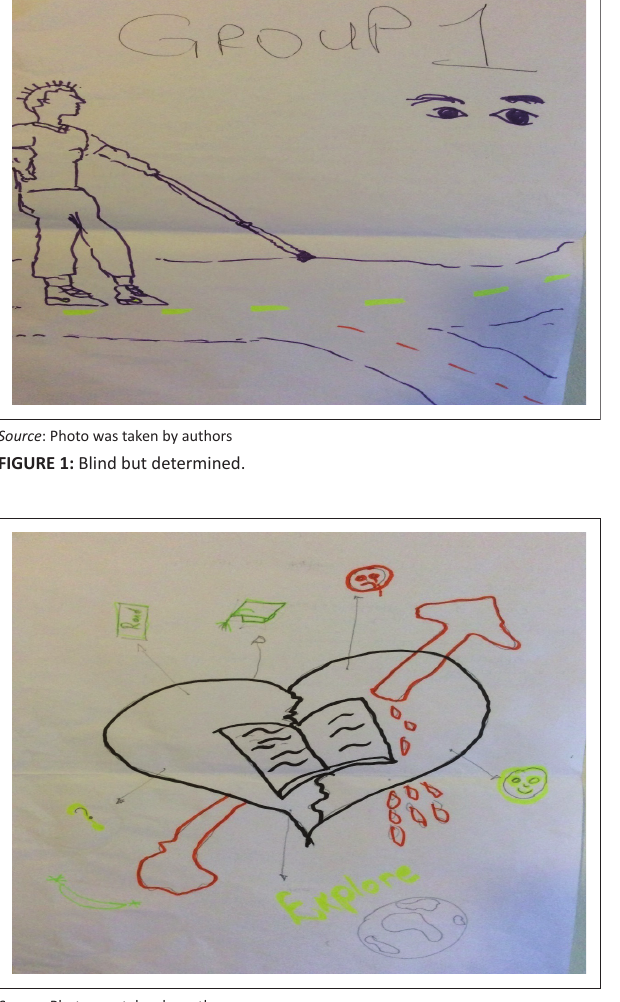
FIGURE 2: Excited but